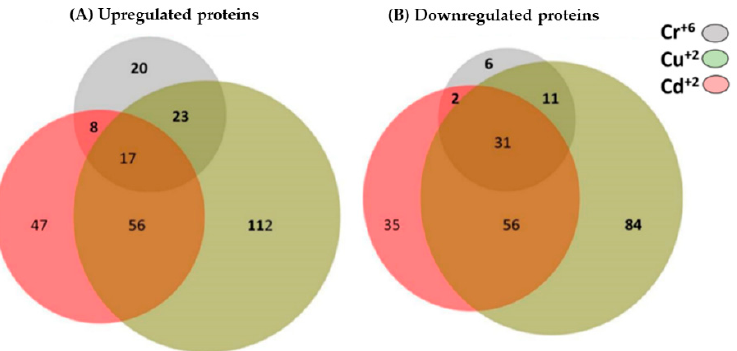
Figure 10. Venn diagram representation of the distribution of upregulated ( A ) and downregulated ( B ) proteins observed under treatment with the heavy metal ions chromium, copper, and cadmium.